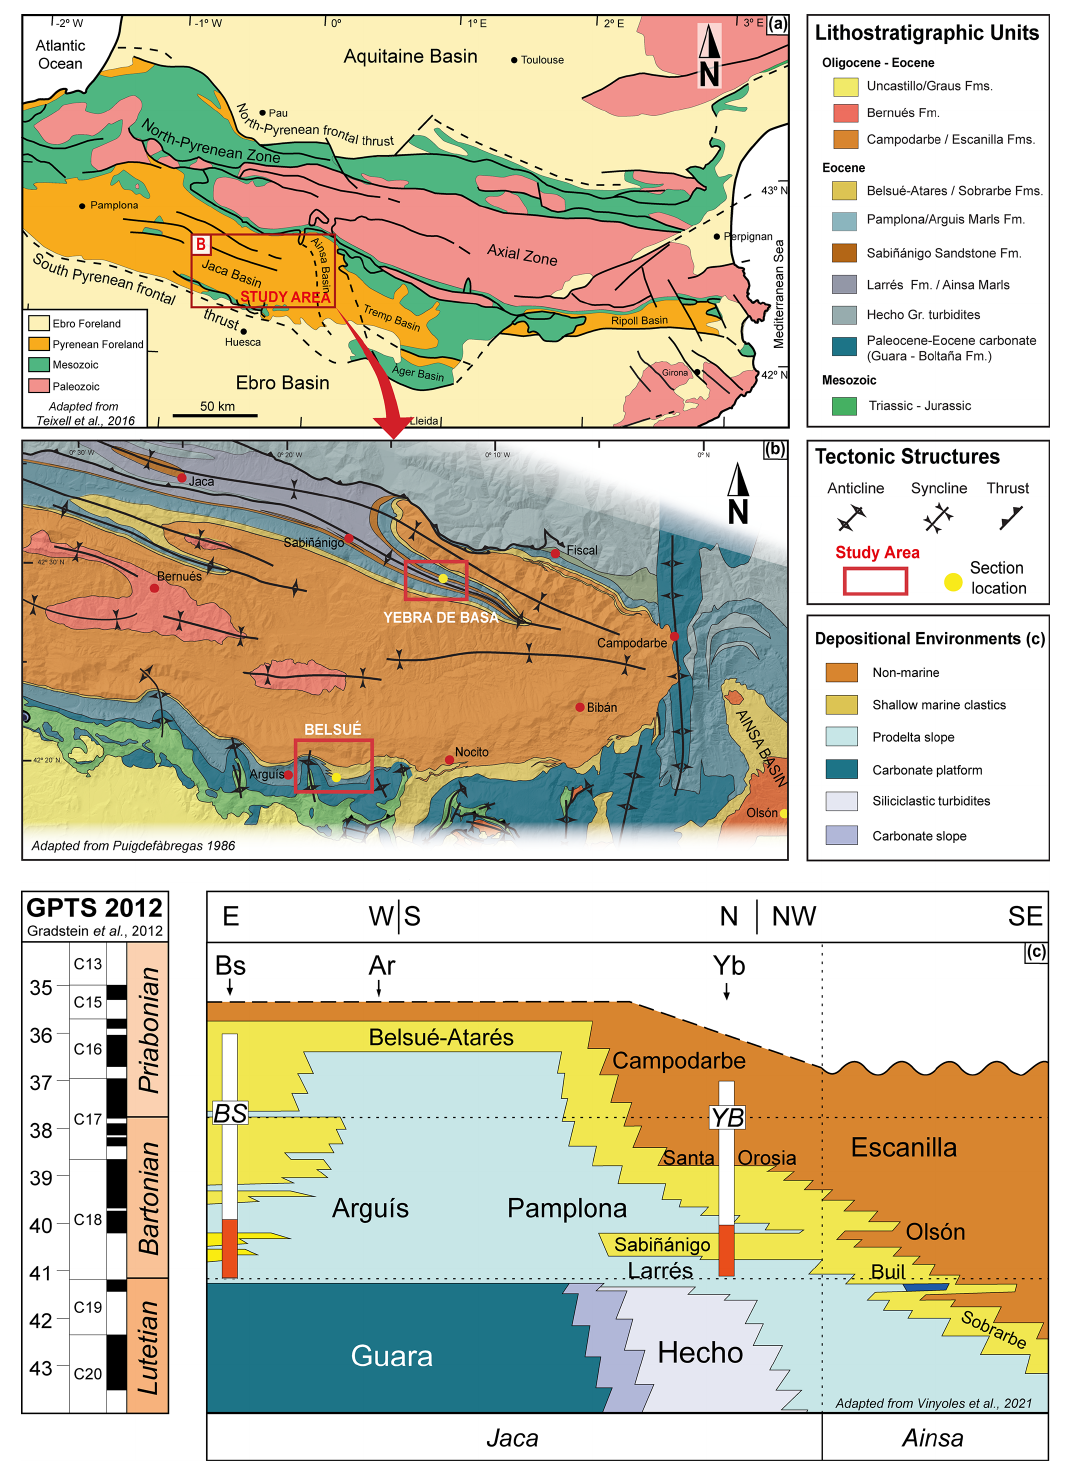
Figure 2. Geological and stratigraphic context of the study area (a) Synthetic geologic map of the Pyrenees and location of the study area in the Jaca basin (red square). Black lines represent the main tectonic structures. Modified from Teixell (1996) and Bosch et al. (2016). (b) Detailed geologic map of the Jaca basin and the study area (Belsué and Yebra de Basa). Modified from Puigdefàbregas (1975) and Boya (2018). (c) Chronostratigraphy of the Ainsa and Jaca basins, showing the westward progradation of all depositional systems. The names of the main lithostratigraphic units are represented in black. The studied sections (in white) are included in the work of Vinyoles et al. (2021), while the location of the geochemical analyses carried out in this paper is highlighted in red. The figure is modified from Vinyoles et al. (2021) and the age model GPTS 2012 from Gradstein et al. (2012). Clim. Past, 19, 533–554, 2023